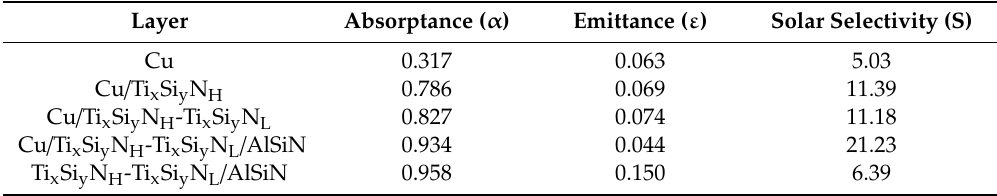
Figure 3. ( a ) Reflectance of different layers and ( b ) coating adhesion strength test. Table 2. The absorptance, emittance, and solar selectivity values. Layer Absorptance ( α )